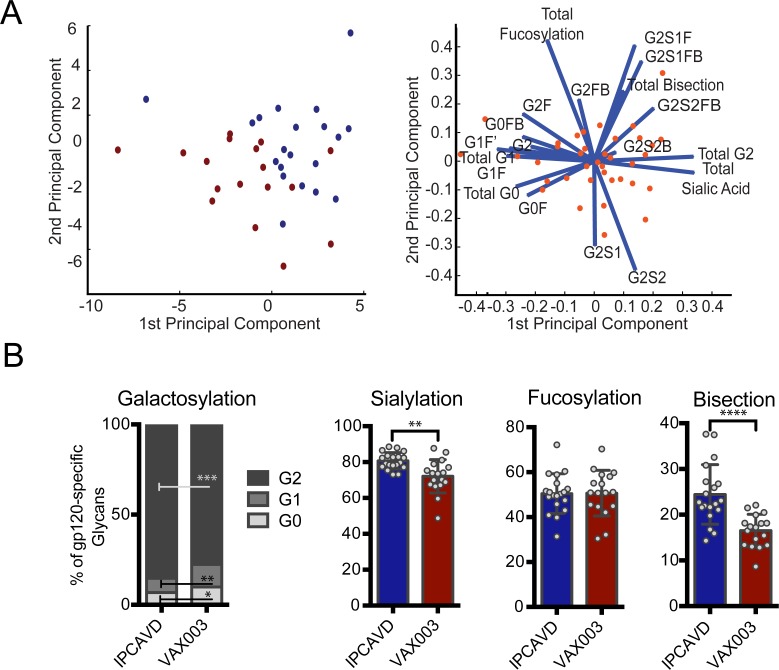
Different vaccines induce distinct vaccine-elicited antibody glycosylation profiles.(A) The antigen-specific IgG glycans from the B003/IPCAVD-004/HVTN 091 (blue) and VAX003 (maroon) studies were compared using PCA. This analysis described 56% of the variation. (B) The mean gp120-specific glycan profiles induced by the B003/IPCAVD-004/HVTN 091 (n = 19) and VAX003 (n = 17) trials were compared using the Mann-Whitney U test (*p<0.05, **p<0.01, ***p<0.001, ****p<0.0001).